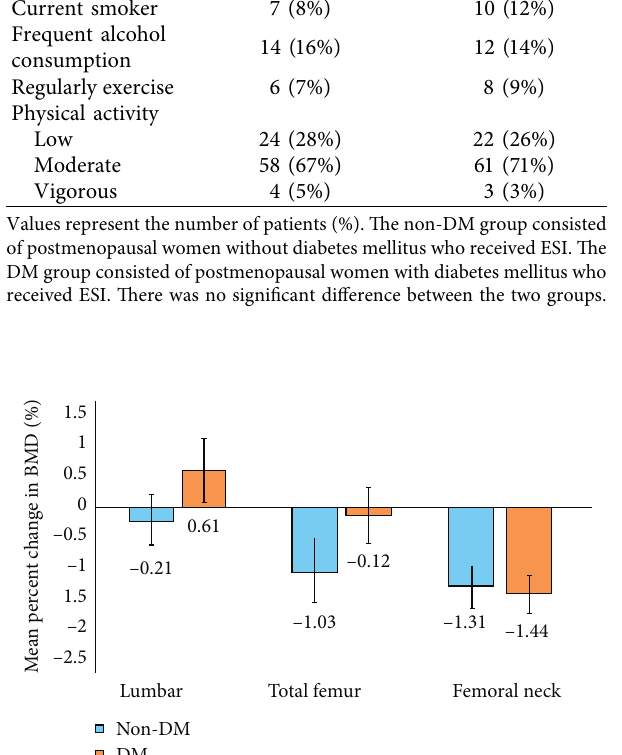
Table 2: Lifestyle characteristics of the patients. Characteristic